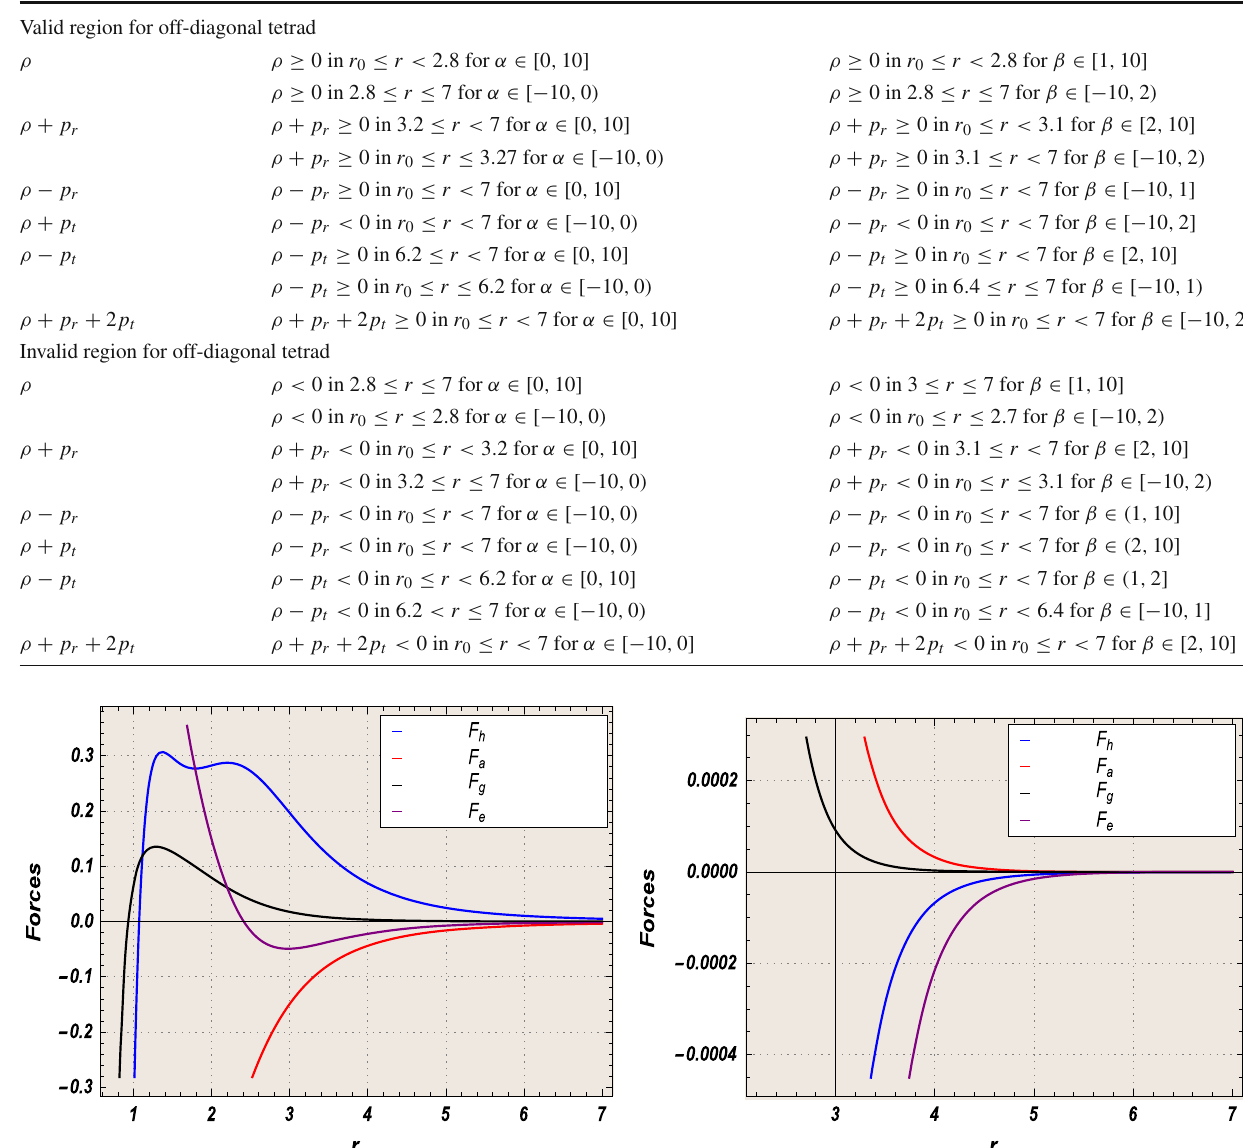
Table 2 Summery of energy conditions in extended teleparallel gravity with off-diagonal tetrad Expressions α β Valid region for off-diagonal tetrad ≤ r < 2 . 8 for α ∈ [ 0 , 10 ρ ρ ≥ 0 in r 0